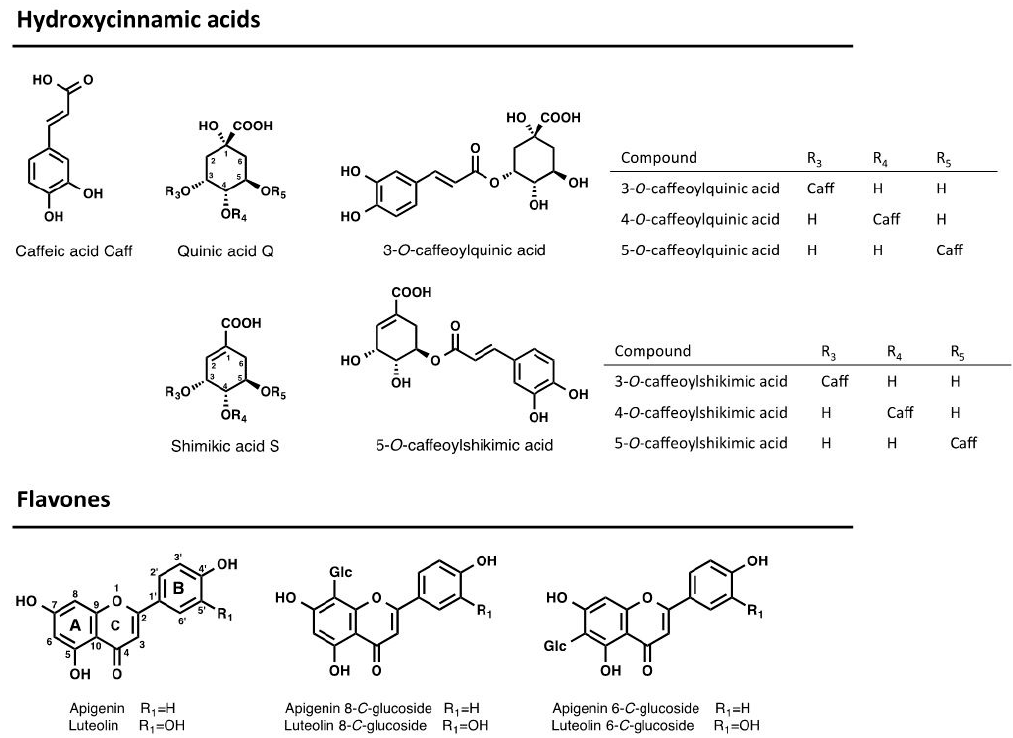
Figure 3. Structure of main components of root and leaflet extracts of Euterpe oleracea ; Glc: glucose.